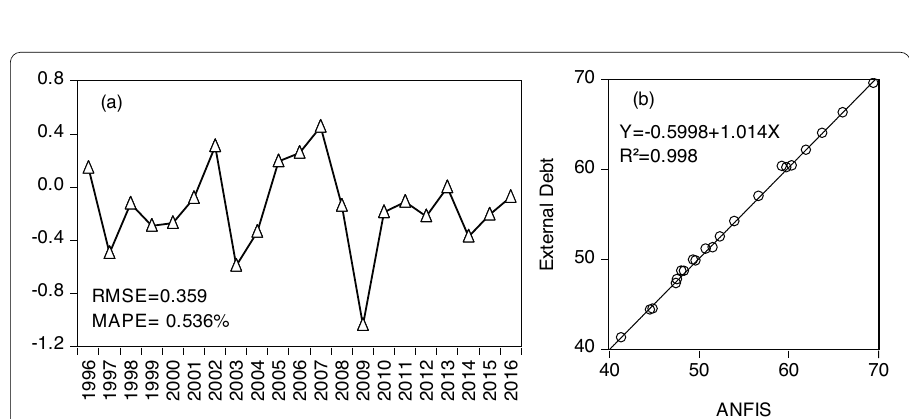
Fig. 3 Plot of the ANFIS prediction against the original series of external debt in Malaysia starting from 1996 to 2016